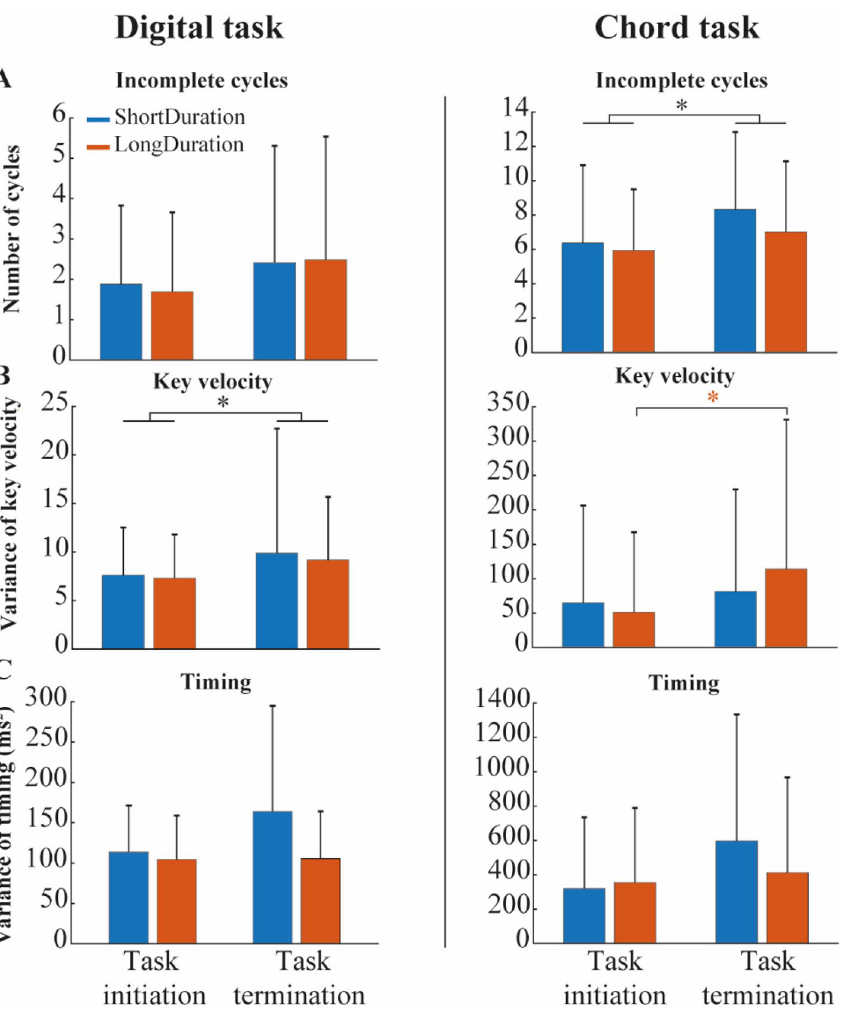
Figure 7. Mean ± standard deviation of ( A ) incomplete cycles, ( B ) key velocity variance, and ( C ) timing variance, for the Digital task (left panel) and the Chord task (right panel). The black * indicate a significant main effect of Time between the initiation and the termination of each repetitive piano task (α = 0.05). The red * indicates a significant difference only for the LongDuration group after post-hoc analysis (α =